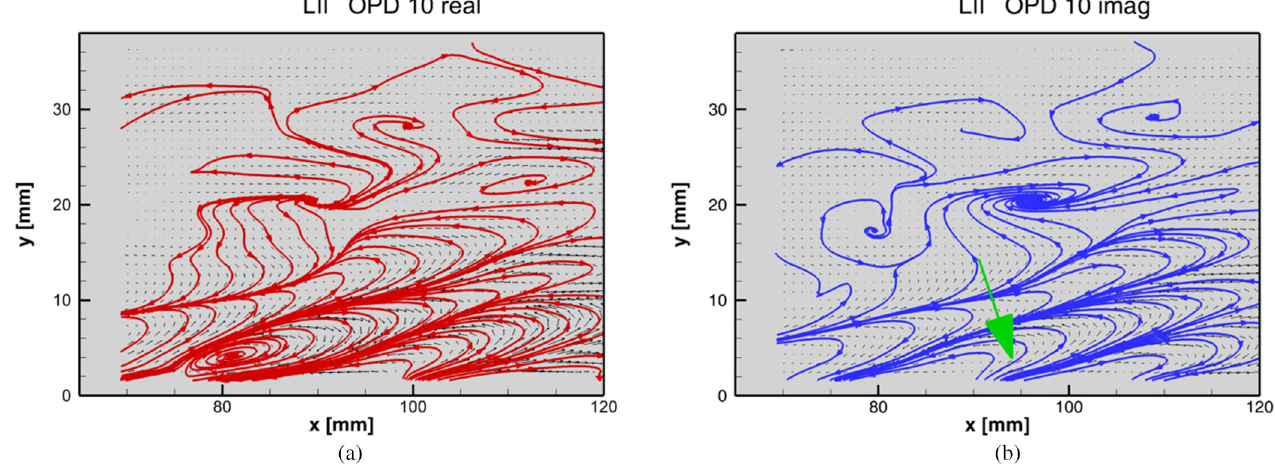
Fig. 23. Topology of the OPD mode in the branch L, zone II, number 10, real (a) and imaginary (b)